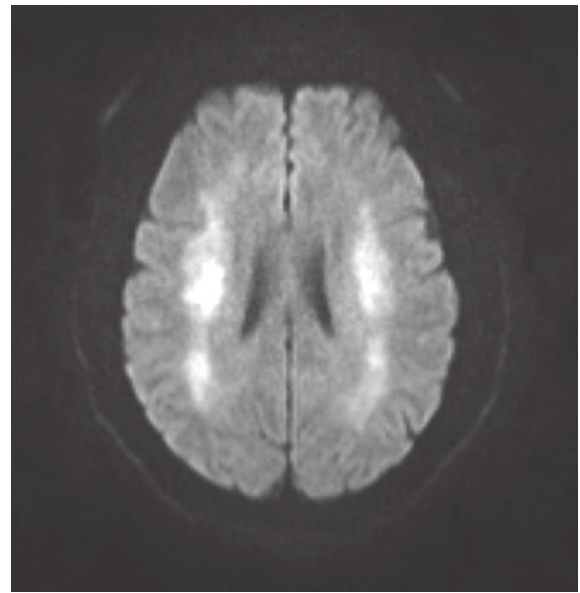
Figure 1: Magnetic resonance imaging findings demonstrating symmetrical bilateral supratentorial restriction in keeping with